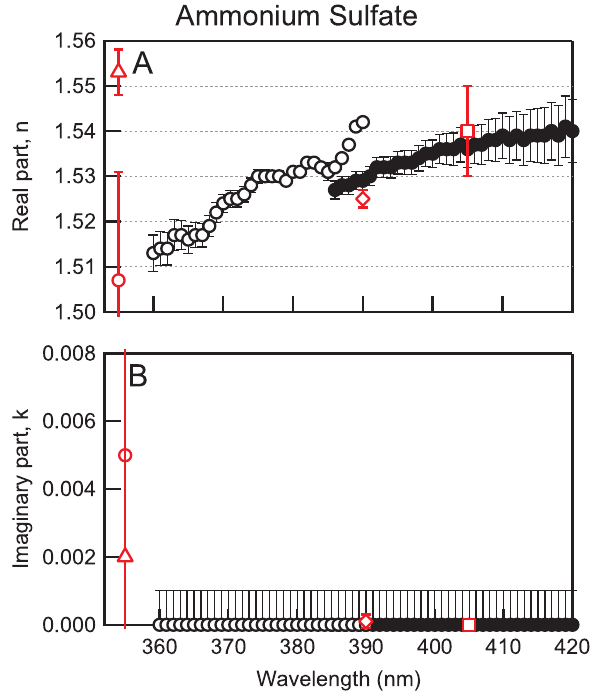
Fig. 6. (a) The real part of the complex refractive index (RI) as a function of wavelength for each wavelength from the BBCES for ammonium sulfate aerosol. Red markers show values reported by Trainic et al. (2011, triangle), Flores et al. (2012, circle), Dinar et al. (2008, diamond), and Toon et al. (1976, square). (b) Similarly, the imaginary part of the